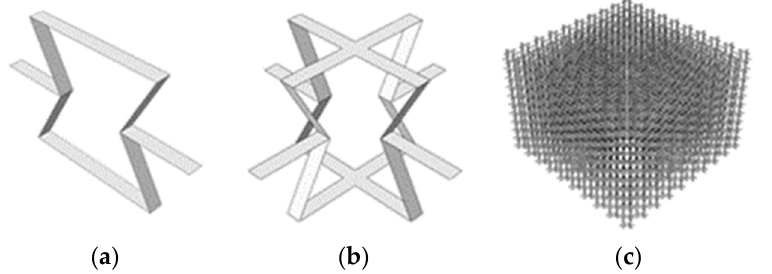
Figure 1. Evolution of three-dimensional re-entrant honeycomb structure. ( a ) Traditional re-entrant honeycomb; ( b ) Representative structural cell (RSC); ( c ) Array of the RSC.